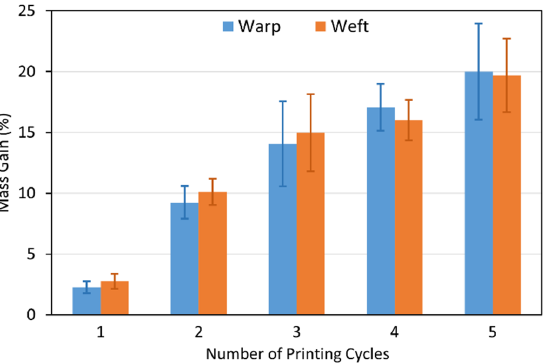
Figure 4. Electroless copper mass gain of textile samples printed with the Cu–Ag NP catalyst at different numbers of cycles and directions.